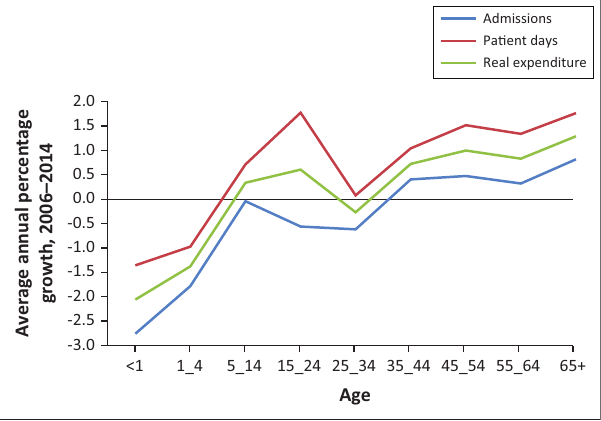
FIGURE 9: Average annual increase in admissions, patient days and real expenditure per 1000 beneficiaries and per age band from 2006 to